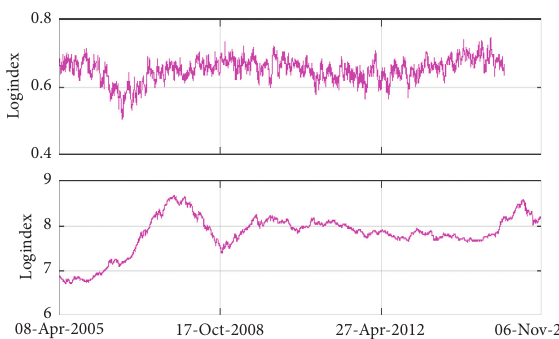
Figure 9: The results of the Hurst exponent when N �